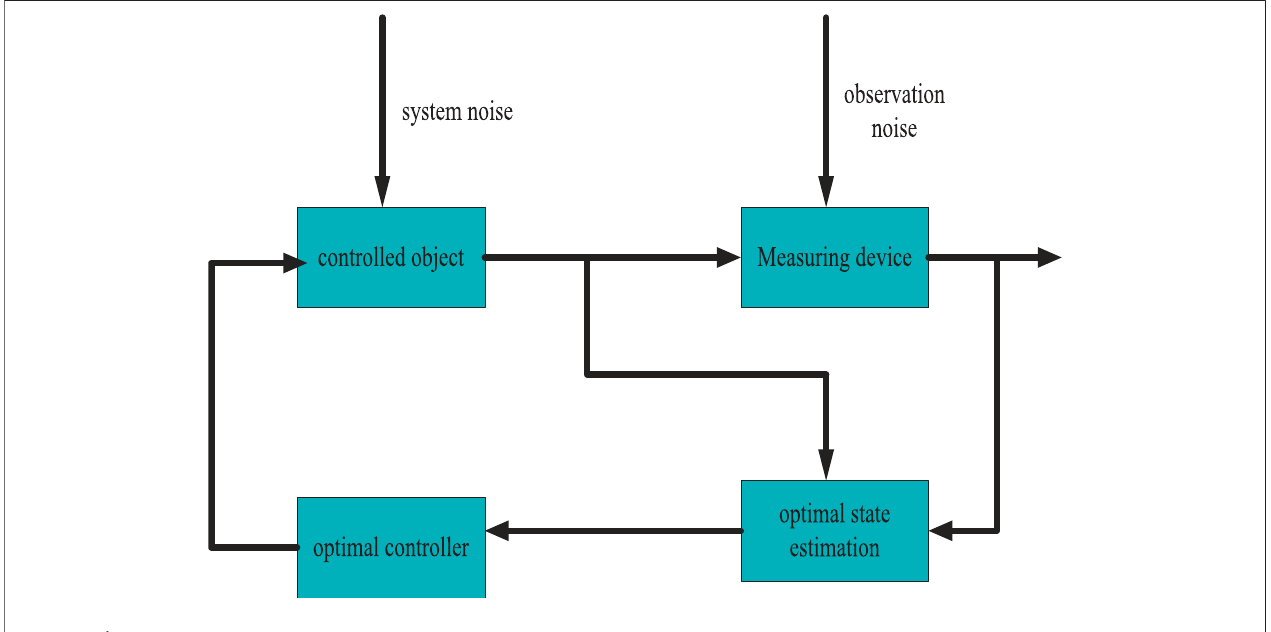
The fi nal state estimation error variance of the EKF algorithm is shown in Figure 3 : As shown in Figure 3 : The static left thigh angle value converges to a certain value and the corresponding angular velocity value and angular acceleration value are almost zero.